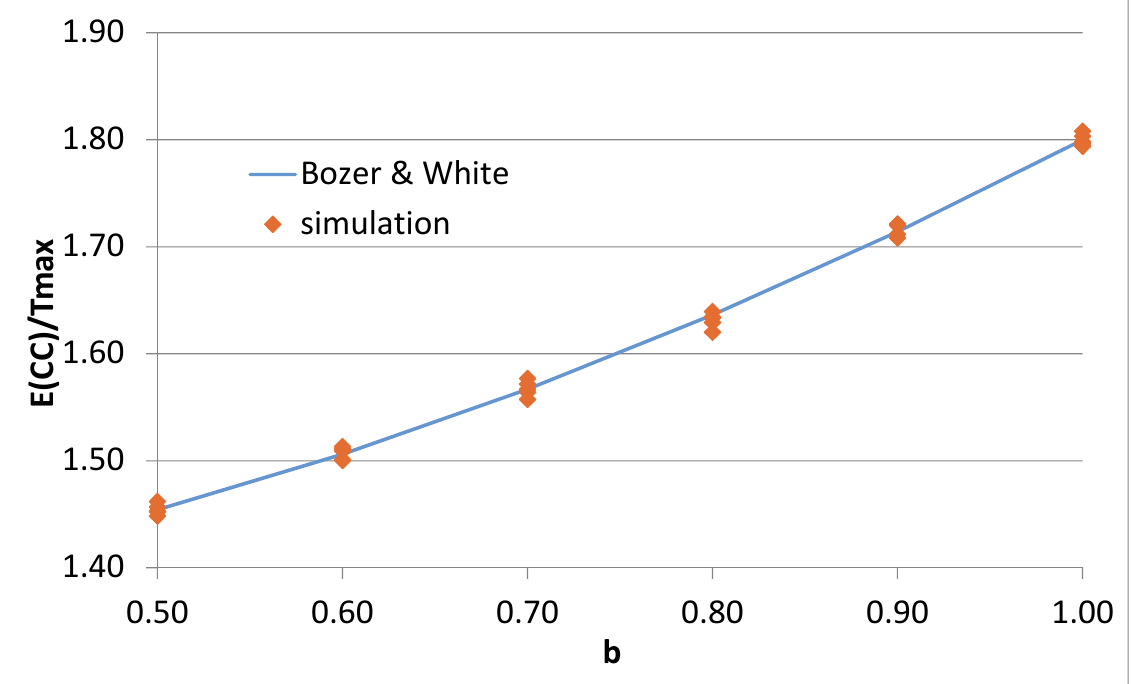
Fig. 2. Benchmark between the Bozer and White’s formula and the